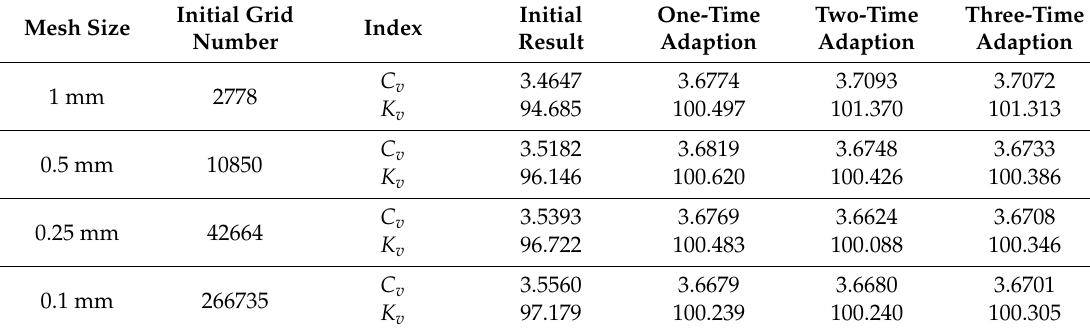
Table 3. y + adaptive results at di ff erent mesh